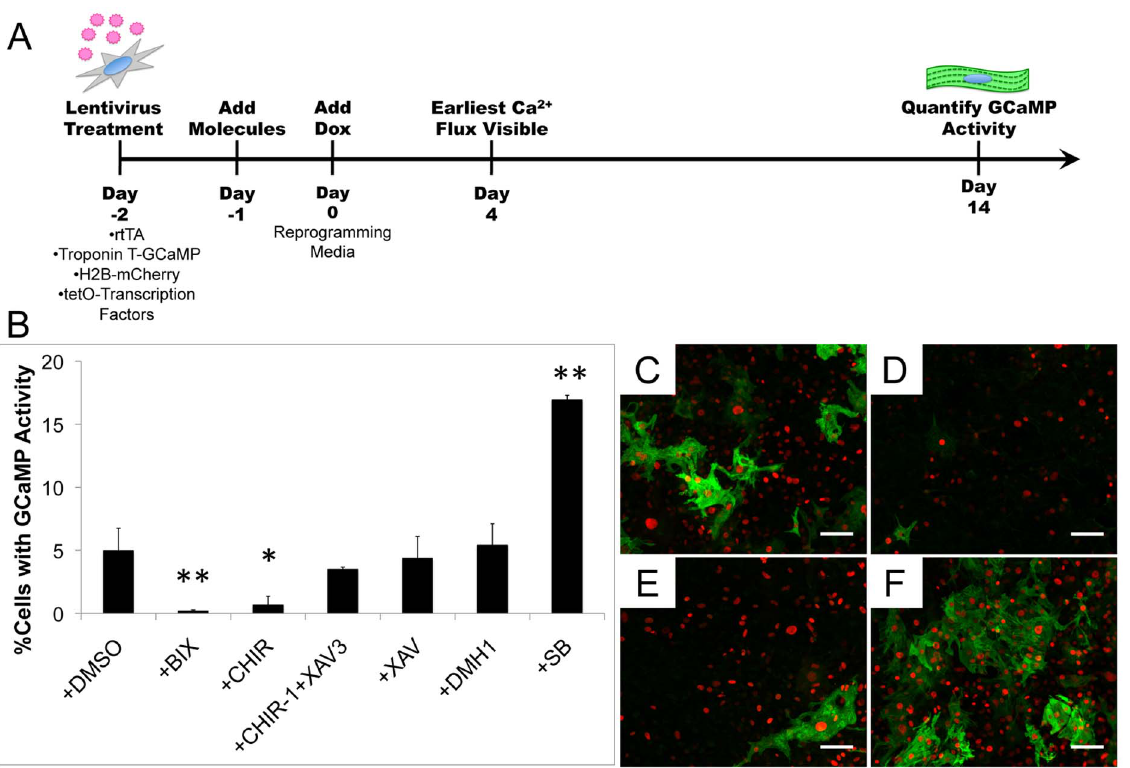
Figure 1. Direct conversion of mouse embryonic fibroblasts to iCMs can be influenced by treatment with small molecules. Schematic of direct reprogramming strategy of MEFs and timeline (A). Percentage of total cells with flashing Troponin T-GCaMP activity for control and small molecule treated MEFs (B). Representative immunocytochemistry images for HNGMT + DMSO (C), or + BIX (D), + CHIR + XAV (E), and + SB (F) treatments for cardiac Troponin T (green) and nuclei (red). * indicates p , 0.05 and ** indicates p , 0.01 compared to + DMSO control. Scale bar is 100 m M. doi:10.1371/journal.pone.0089678.g001 Microarray Suite 5.0 and PartekGS Software. Pathway and